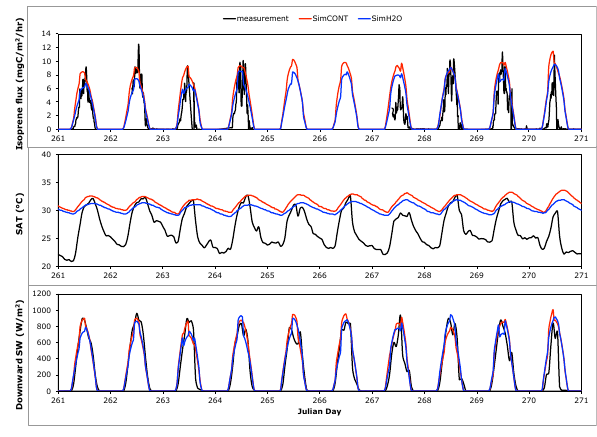
Fig. 7b. (a–f) Time evolution of isoprene emission flux, surface Figure 7b. Results for Manaus during September 17-27 2004. air temperature (SAT) and downward shortwave (SW) radiation at the tropical measurement sites. Measurements are shown in black (where data is available). Model climatological results are averages of 10 simulation years in SimCONT (red) and SimH2O (blue). (b) Manaus during 17–27 September 2004.